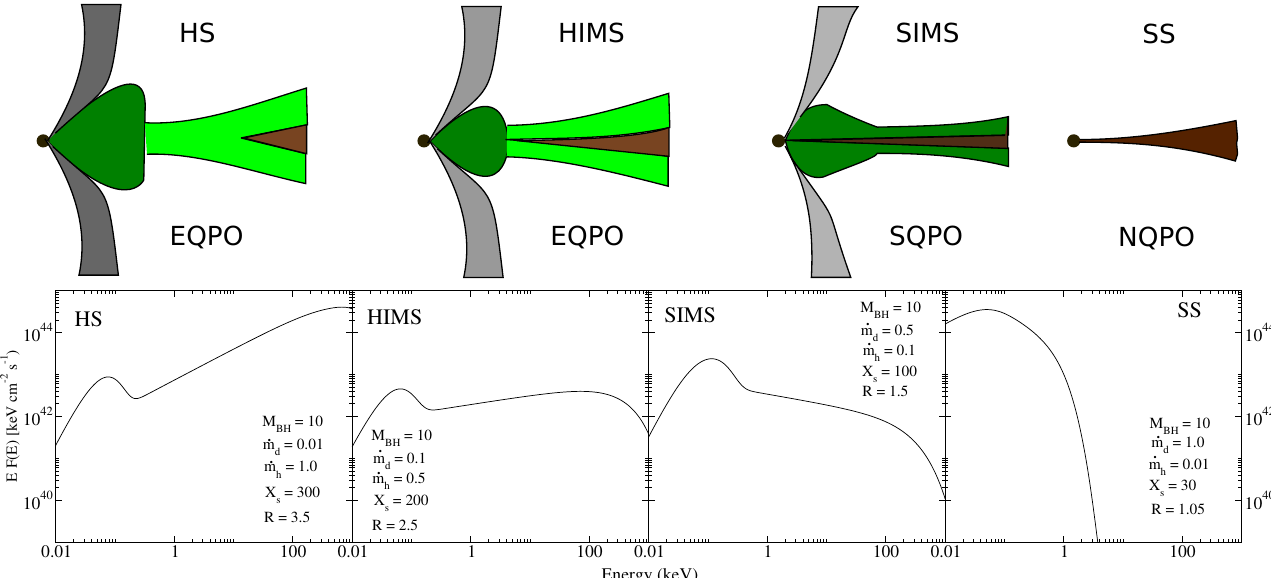
Figure 1. In upper panel, cartoon diagrams of four commonly observed spectral states under TCAF solution are shown (adopted from [38]). Brown, light green, dark green and grey region represent Keplerian disk, sub-Keplerian halo, CENBOL and jet, respectively. An outbursting black hole evolves as HS both rising and declining HS and HIMS show monotonically evolving type-C (low frequency) QPOs, and SIMS shows sporadic type-B or type-A QPO. In soft sate these QPOs are absent. Here, EQPO means evolving QPO; SQPO means sporadic QPO; NQPO means no QPO. In the bottom panel, theoretical spectra corresponding to the top paneled spectral states are shown. These spectra are generated using five input parameters ( M BH in M R ), whose values are marked inset. The cartoon diagram and corresponding spectra are only for illustrative purpose.